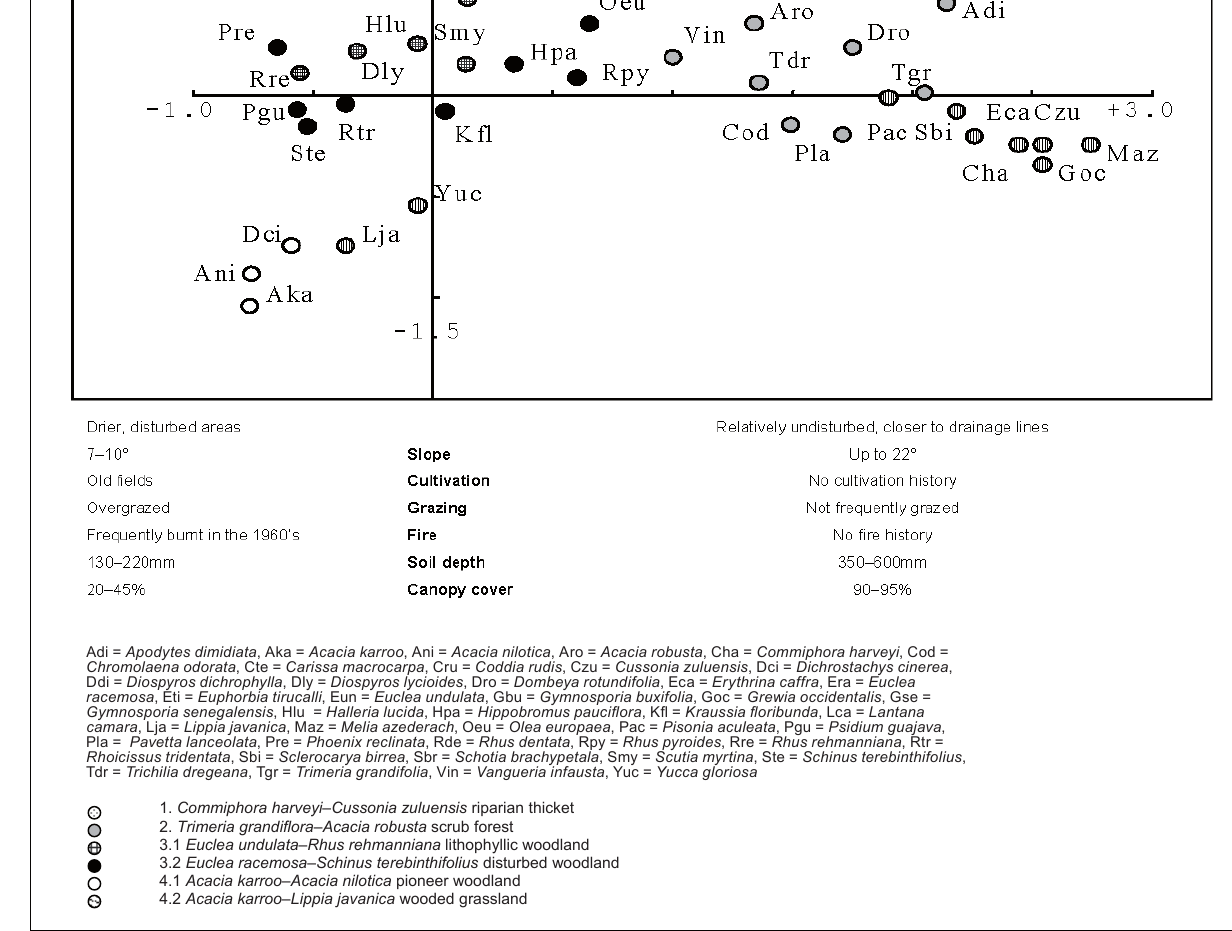
Figure 7 CA ordination depicting the distribution of species in areas with no disturbance closer to drainage lines and disturbed areas of drylands. Eigen values for axes one and two are 0,558 and 0,308 respectively, representing cumulatively 34,6% of total variance.